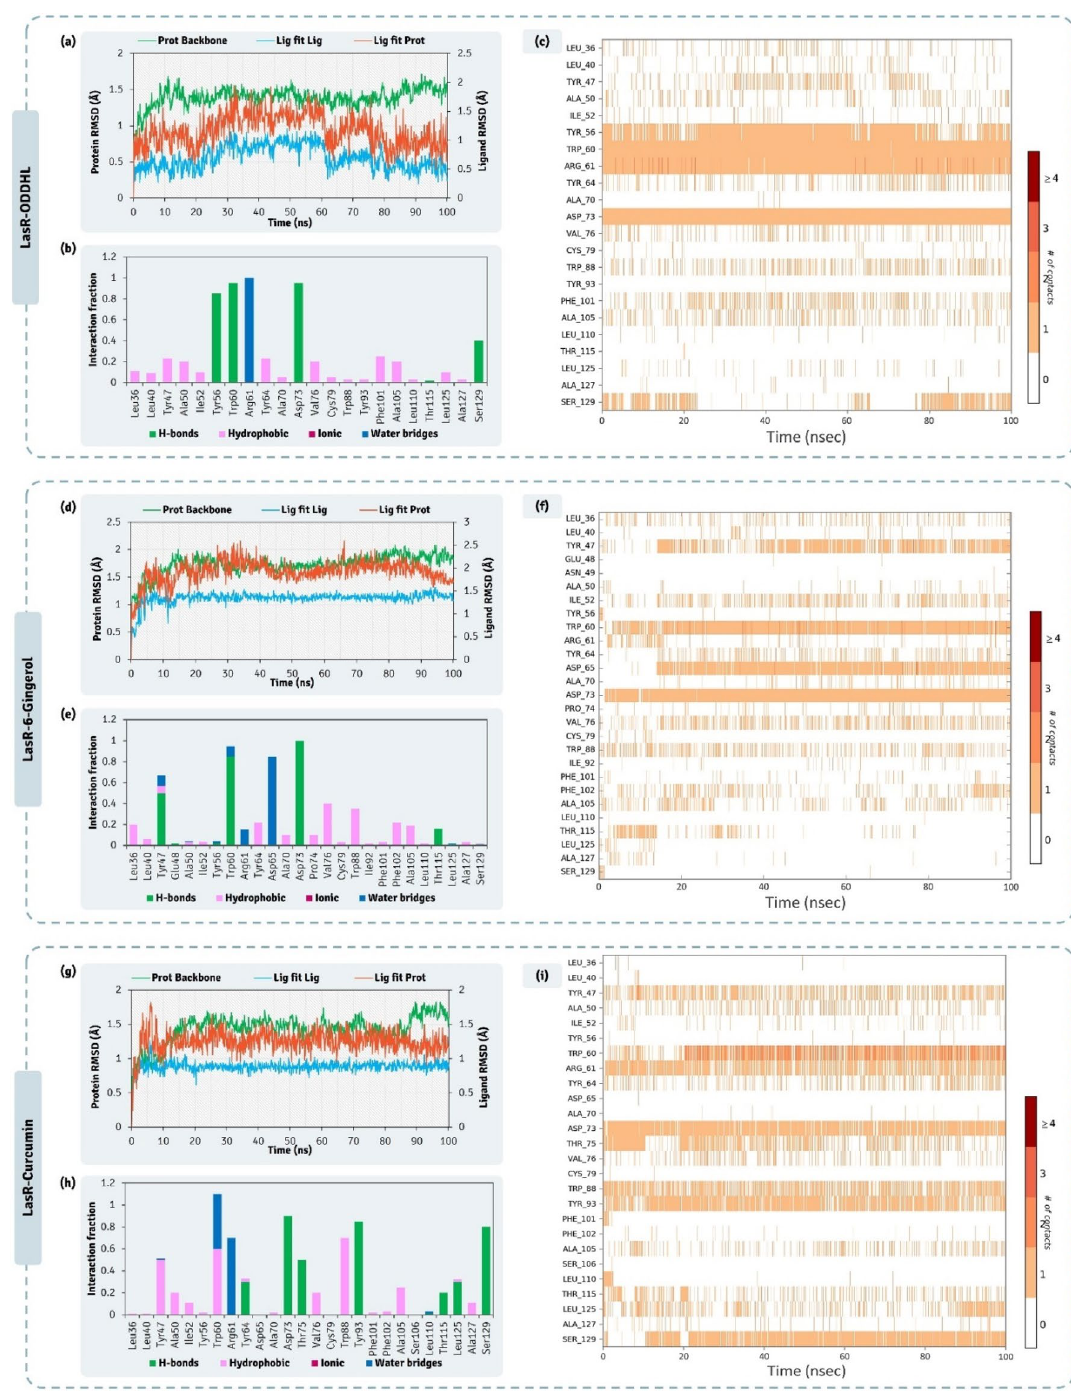
Figure 6. 100 ns MD simulation trajectory representing the RMSD assessment, ligand-receptor interaction profile and ligand-receptor interaction timeline for LasR-ODDHL, LasR-6-Gingerol, and LasR-Curcumin